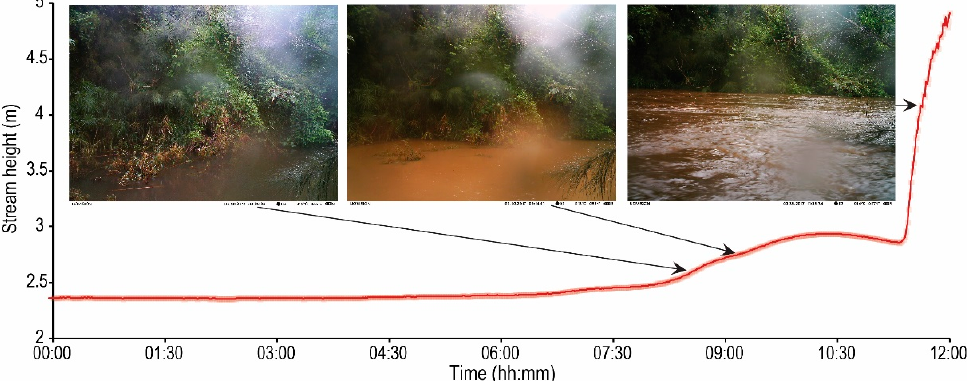
Figure 7. Selected time-lapse images recorded during the initial phase of the flood event showing rapid discoloration associated with a 20 cm rise in stream height.